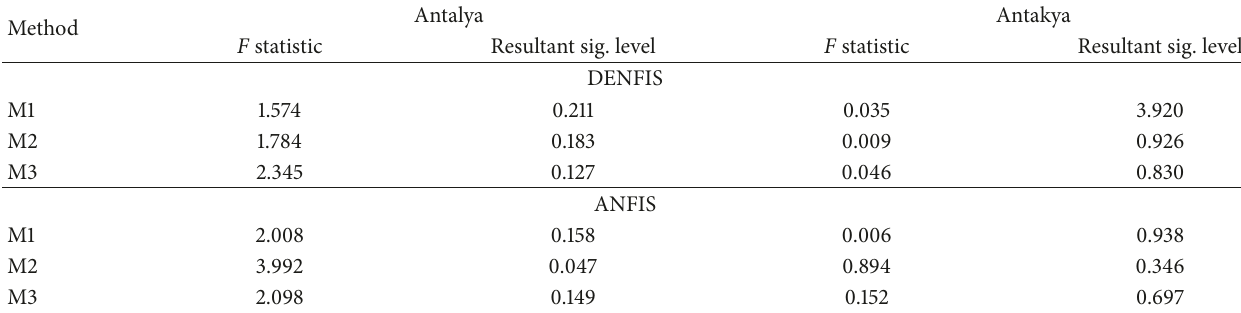
Table 5: Analysis of variance (ANOVA) for pan evaporation estimation in the test